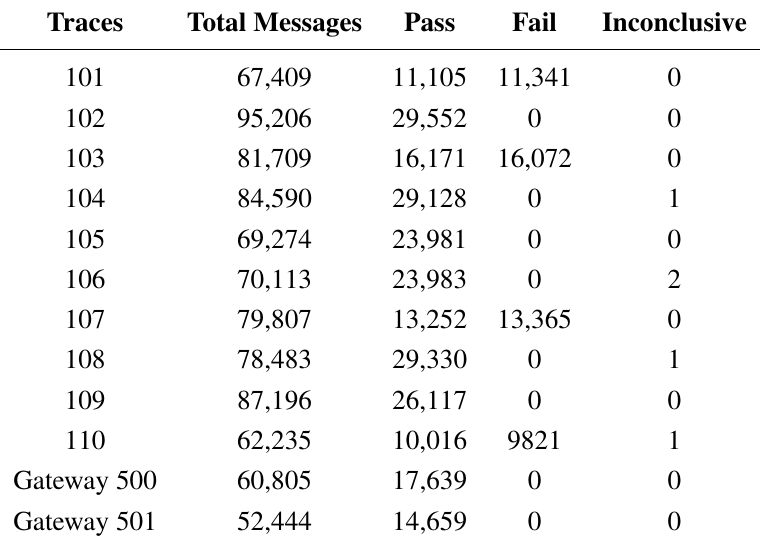
Table 4. Test results for Property 3 (Day 1).